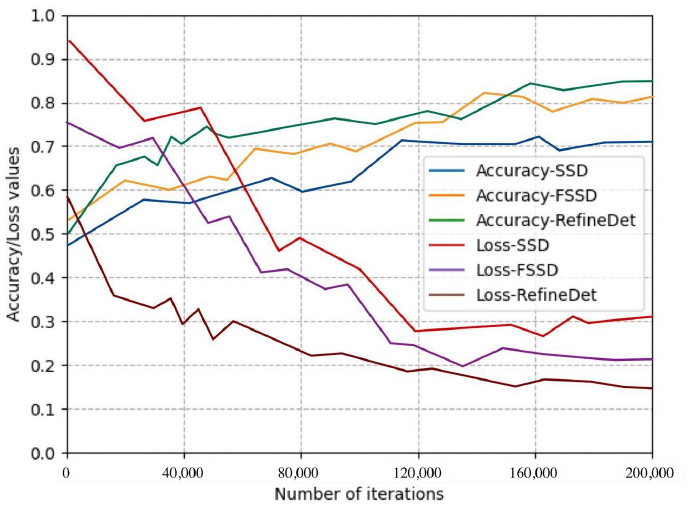
Figure 10. Training curves of accuracy and loss against number of iterations on SSD series.